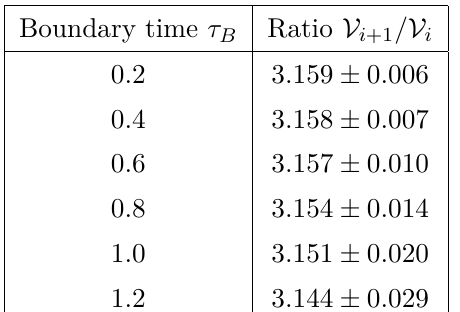
Table 1 . Numerical value of the ratios V i +1 / V i evaluated at various boundary times τ B . We determined the mean value and the standard deviation from the results obtained by varying i ∈ { 1 , . . . 10 } in the function δ = 10 − i +2 2 . The results must be compared with the analytic expectation √ 10 ’ 3 . 162 .